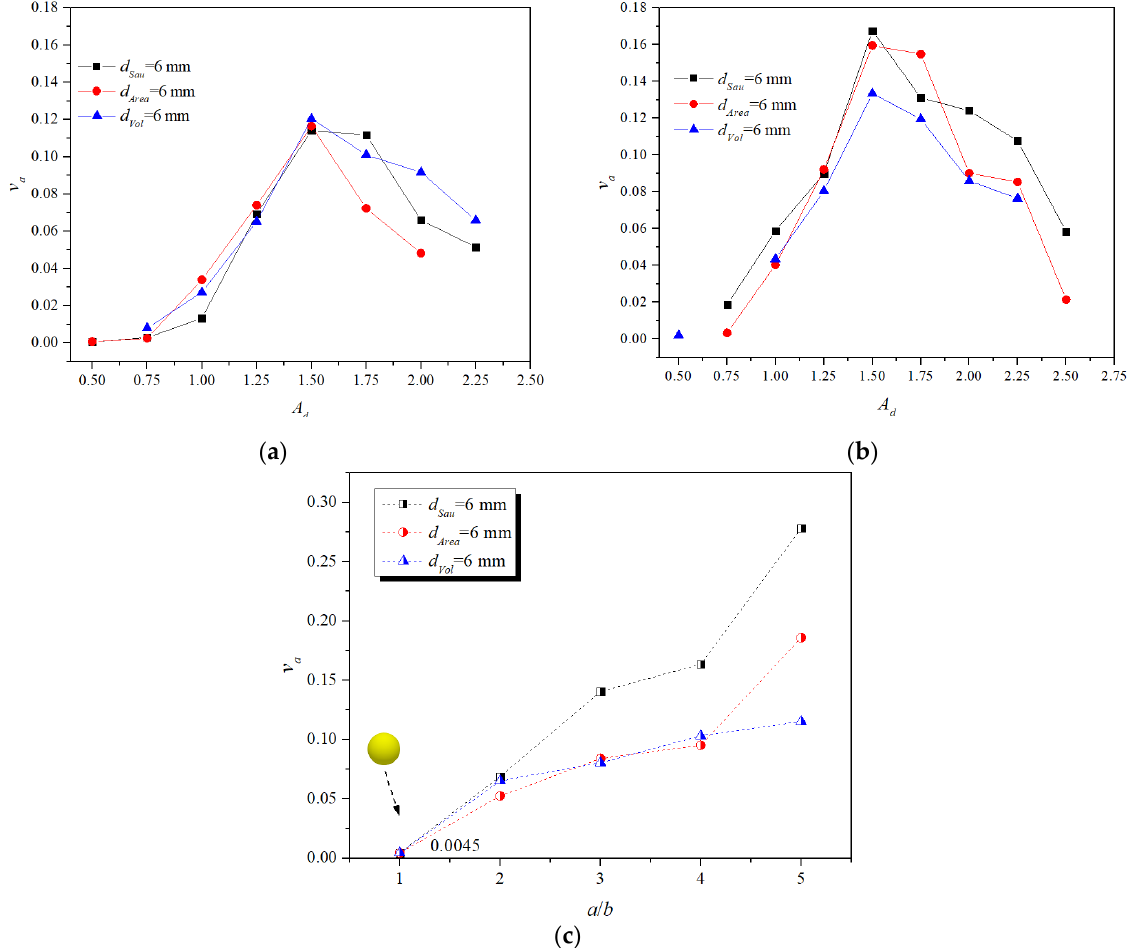
Figure 4. ( a ) v a as a function of A with f = 20 Hz and a / b = 2.0; ( b ) v a as a function of A with f = 20 Hz and a / b = 3.0; ( c ) v a as a function of a / b , with f = 20 Hz and A = 1.25· d s . The yellow sphere means the intruder of a / b = 1.0.